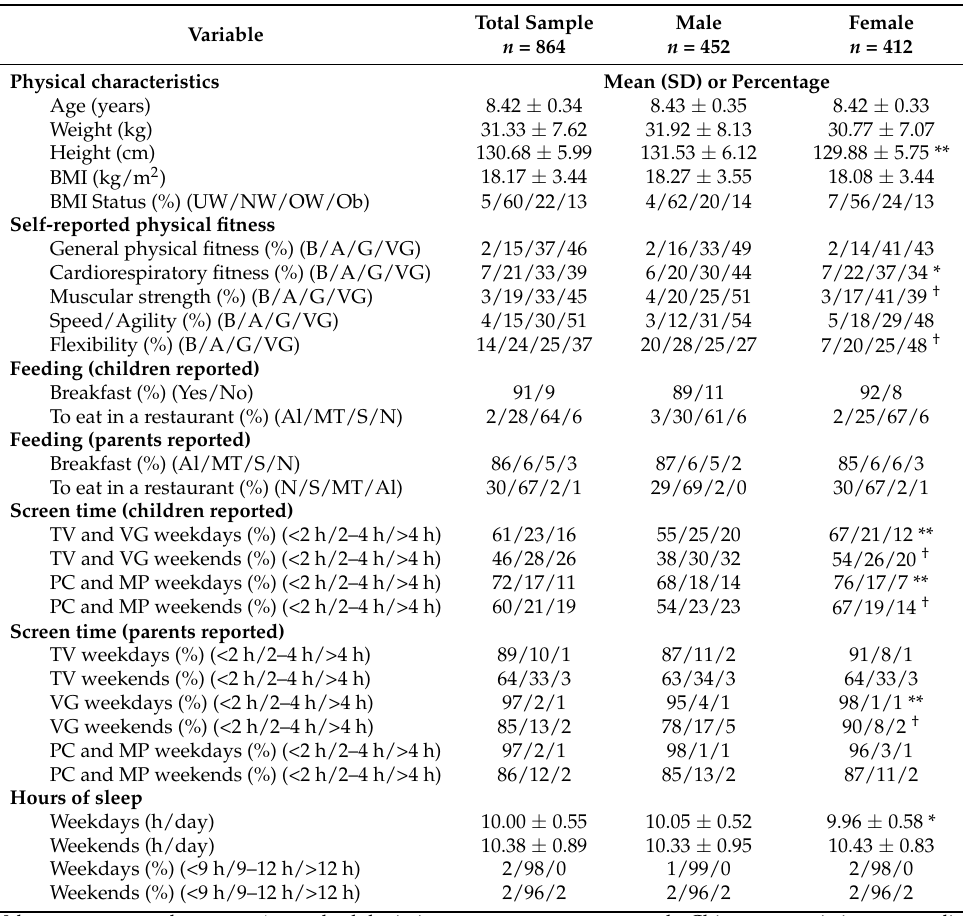
Table 1. Descriptive characteristics of schoolchildren by